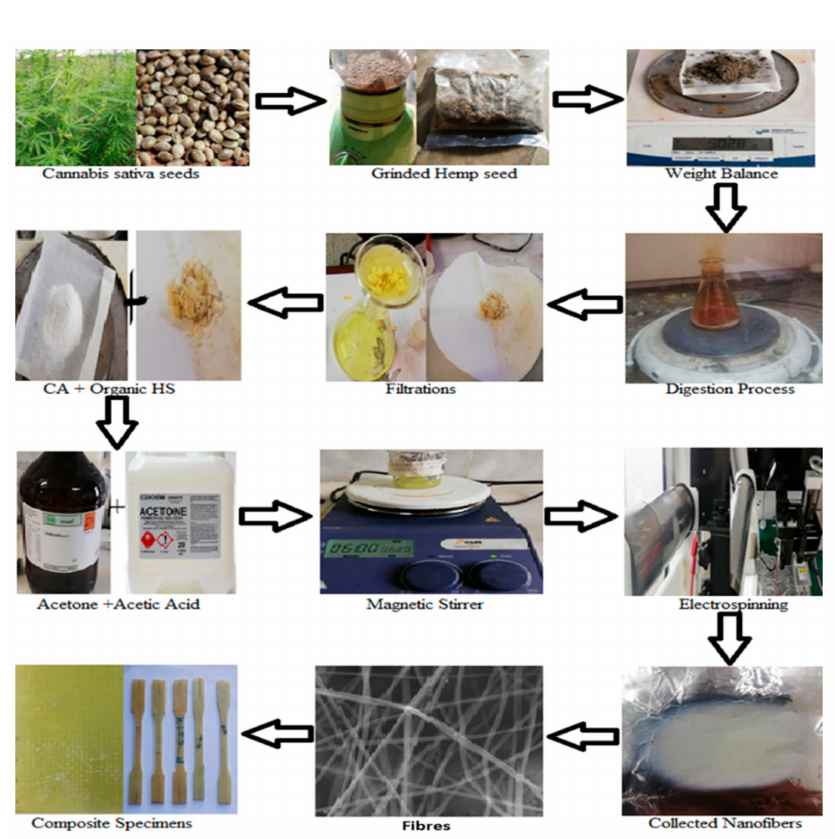
Figure 2. Overall Experimental process of nanofibers. The homogeneous polymer solution was loaded into a syringe and placed in the syringe pump to electrospin horizontally on the collector. Electrospinning processes were carried out at room temperature, and the details of the major parameter and equipment are given in Table 2. When the experiment was performed once, the end of the needle was cleaned regularly to keep the formation of big drops at the end of